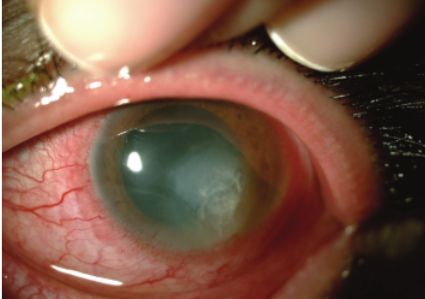
Figure 1: The right eye of the case 1 with deep corneal ulcer and stromal infiltration.